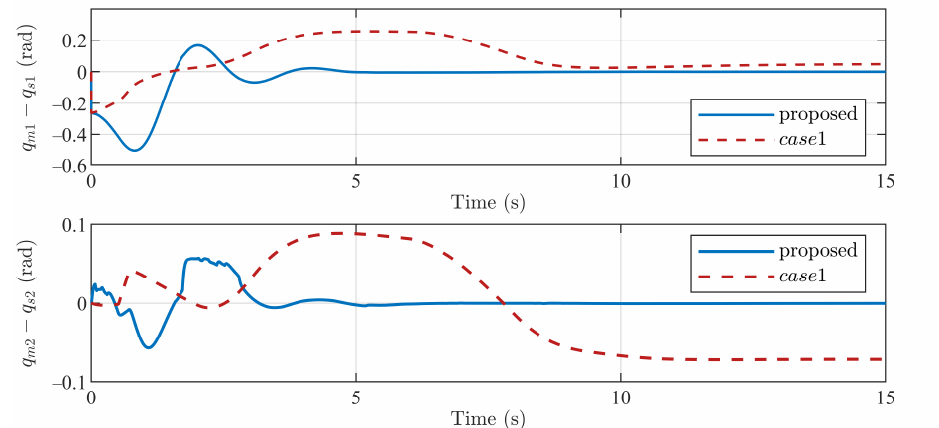
Figure 12. Comparisons of joint tracking errors based on the proposed method and the method in Case 1.